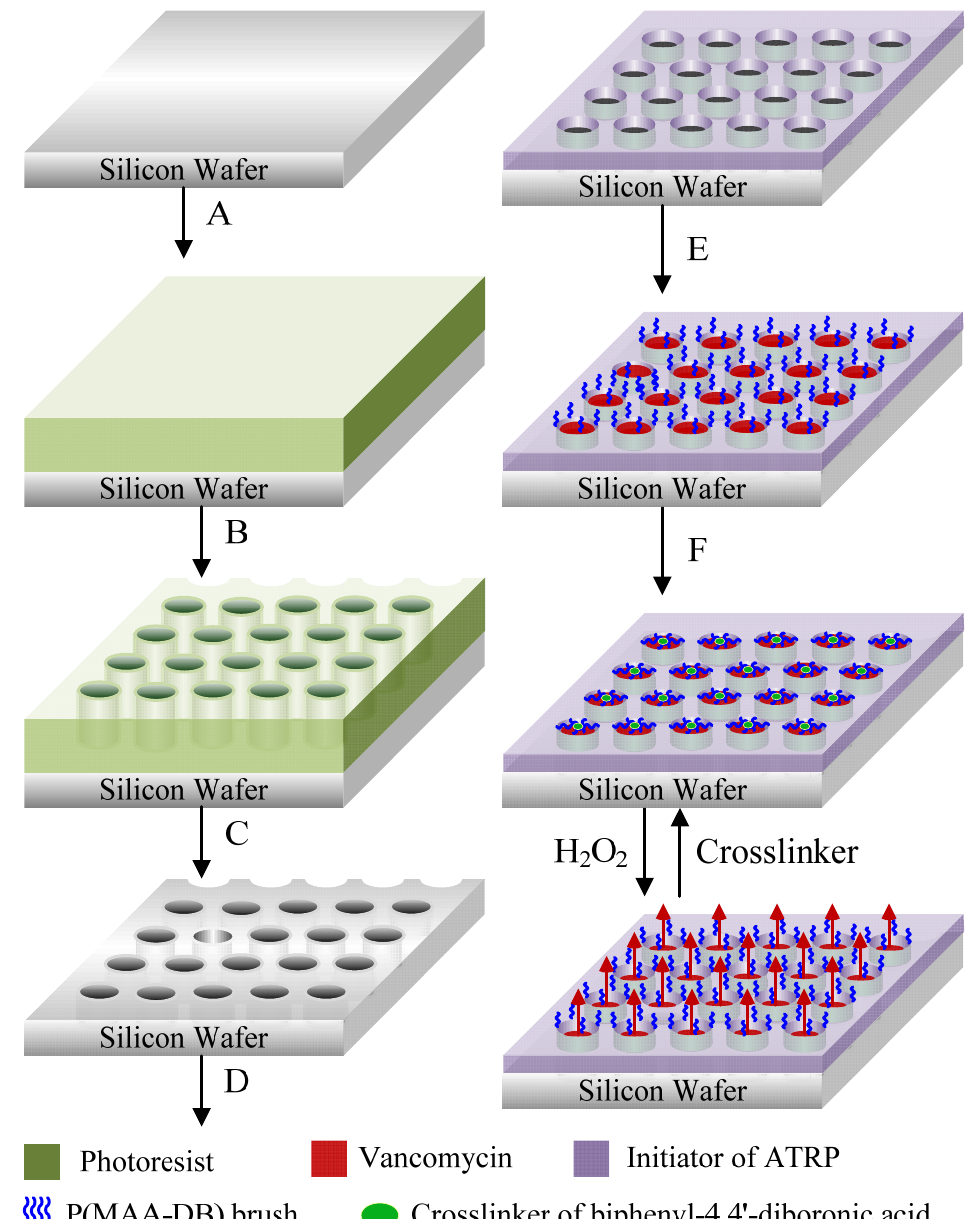
Scheme 2. Illustration of the preparation processes of a polymer-capped system for ROS-triggered drug release. A and B: Photoresist was coated on silicon wafers to pattern hole array of